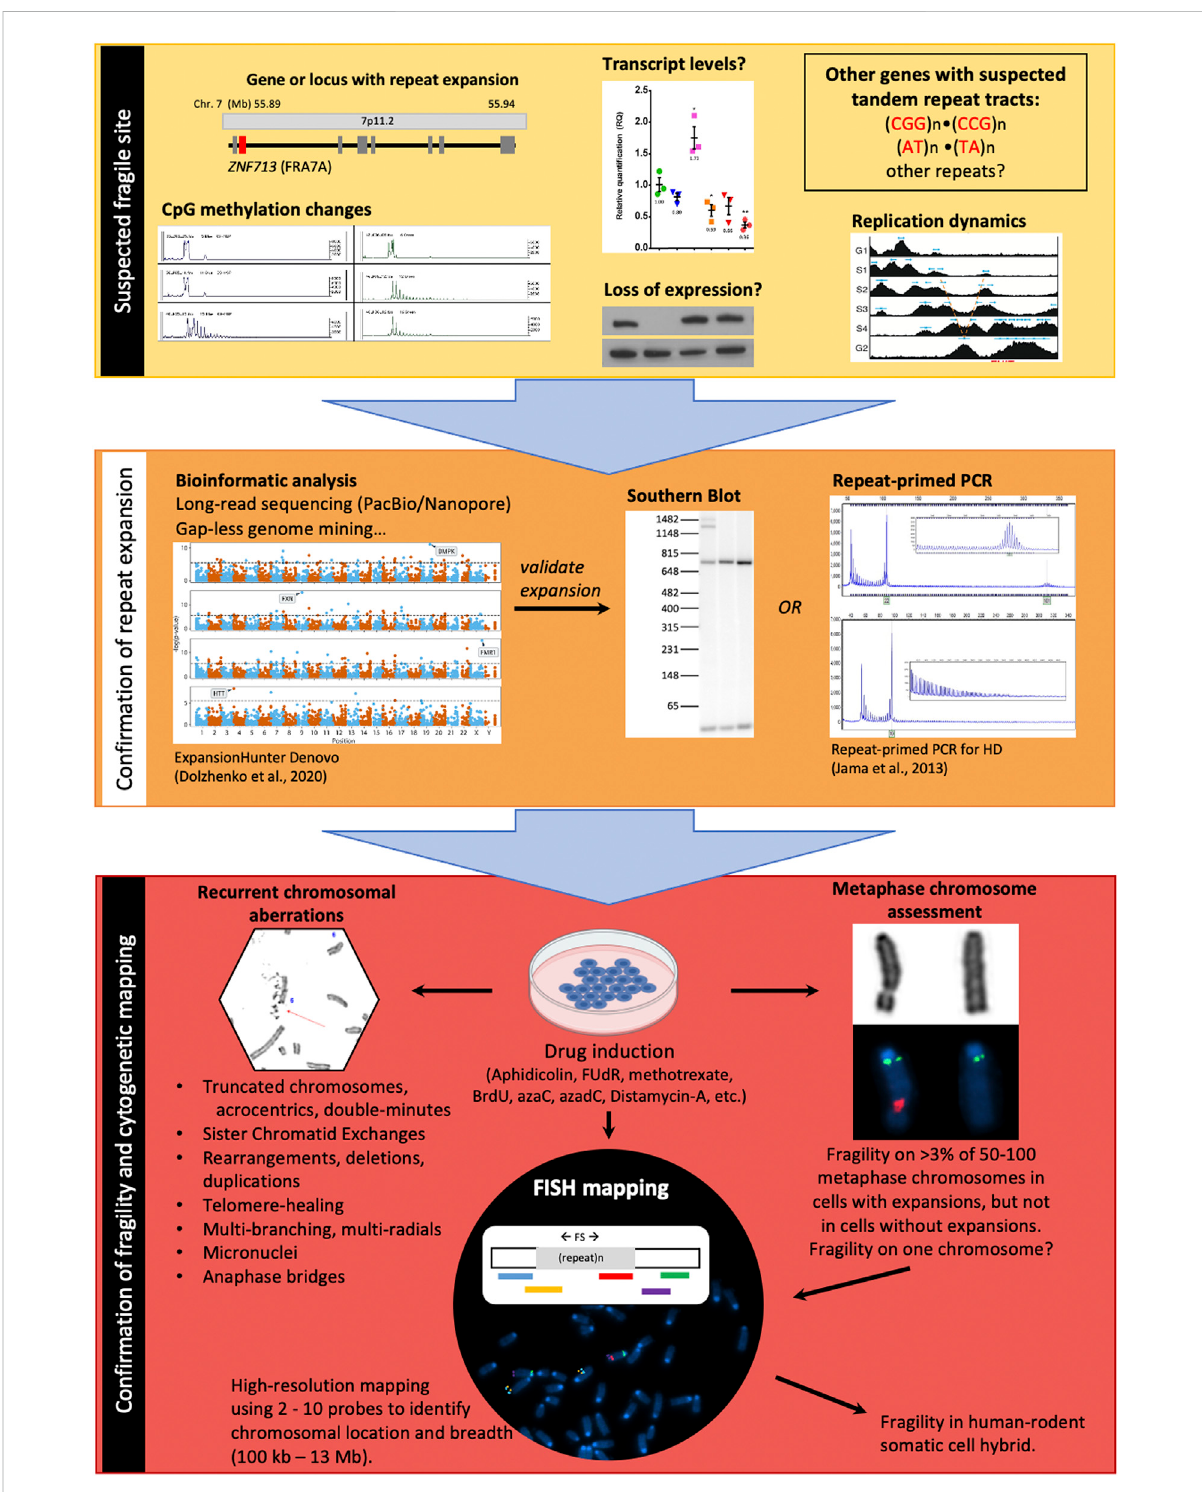
FIGURE 3 Strategies to identify and map a fragile site. Yellow segment – Repeat-associated FS breakpoints may be suspected based upon various genetic and epigenetic landmarks in normal cells. Large genes, changes in CpG methylation patterns on one chromosome, loss of expression (transcript or protein), a V-shaped replication timing pattern, and the presence of tandem repeat sequences (CGG)n, (GGGGCC)n, and (AT)n are all pre-disposing factors for FSs. Orange segment – con fi rmation of a repeat expansion at the suspected FS can fi rst be carried out by bioinformatic analysis of sequenced reads, followed by validation via Southern blot (gold standard) or repeat-primed PCR. Red segment – The fi nal step of FS localization requires drug treatment to induce expression of the FS, followed by characterization of metaphase spreads for fragile site hallmarks and FISH-based mapping of the FS using two or more coloured FISH